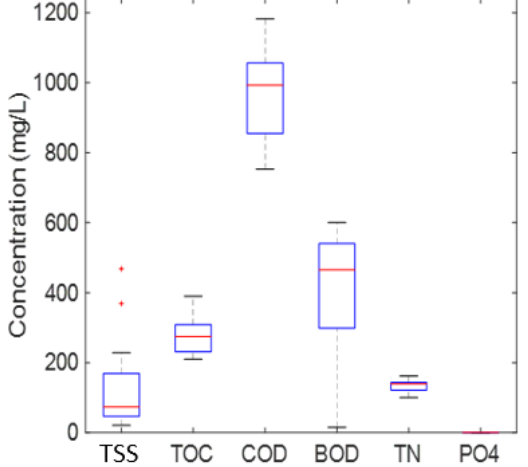
Figure 5. Produced water composition_Global parameters. Table 2. Produced water physico-chemical characteristics.